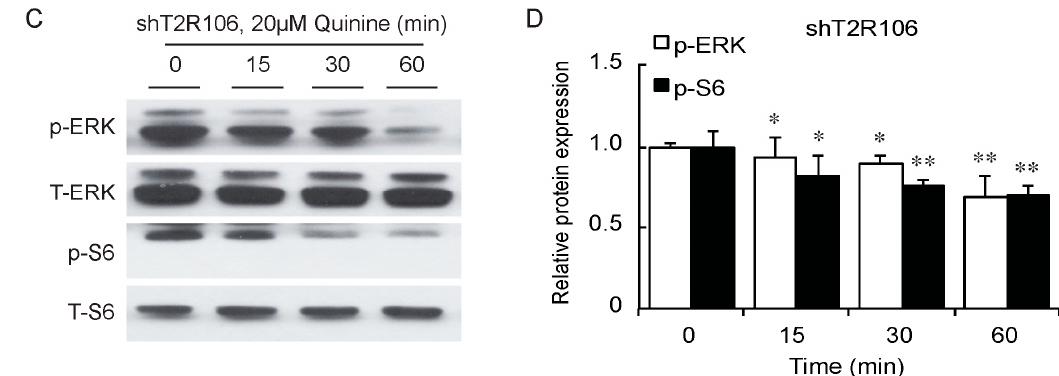
Figure 7. T2R106 knockdown impaired quinine mediated ERK/S6 signaling activation. ( A ) Expression of phospho-ERK (p-ERK) and phospho-S6 (p-S6) proteins in shScramble cells by Western blot; ( B ) Quantification of p-ERK and p-S6 protein expression; ( C ) Expression of p-ERK and p-S6 proteins in shT2R106 cells by Western blot; and ( D ) Quantification of p-ERK and p-S6 protein expression. Control and T2R106 knockdown mouse preadipocytes were serum starved for 2 h with HBSS, cells were then treated with 20 µM quinine for the indicated time. Cell lysates were then used for immunoblotting for ERK, p-ERK, S6 and p-S6 by Western blot (* p < 0.05, ** p < 0.01, *** p < 0.001, indicated fold change compared with 0 min).